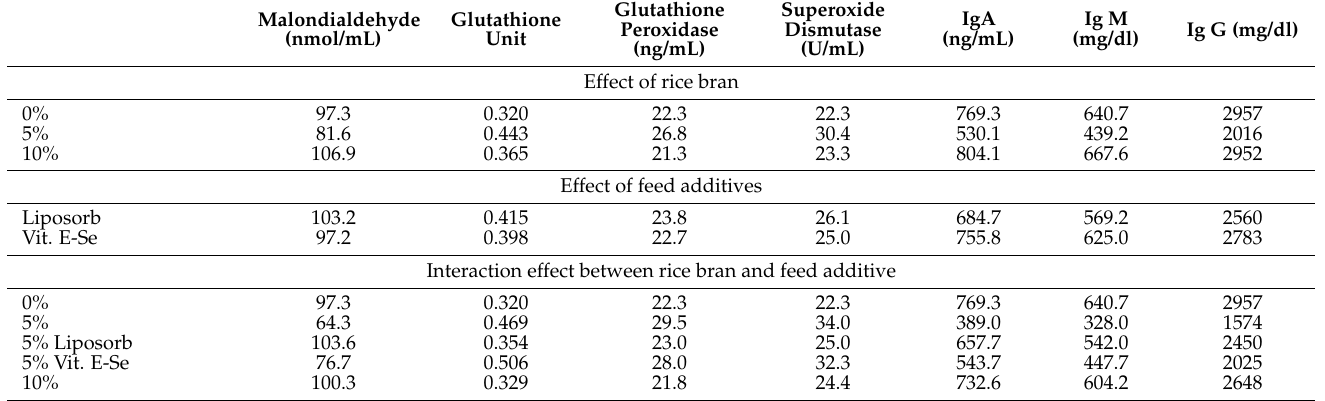
Table 7. Antioxidant and immunological indices of broiler chickens as affected by dietary rice bran treatments during the